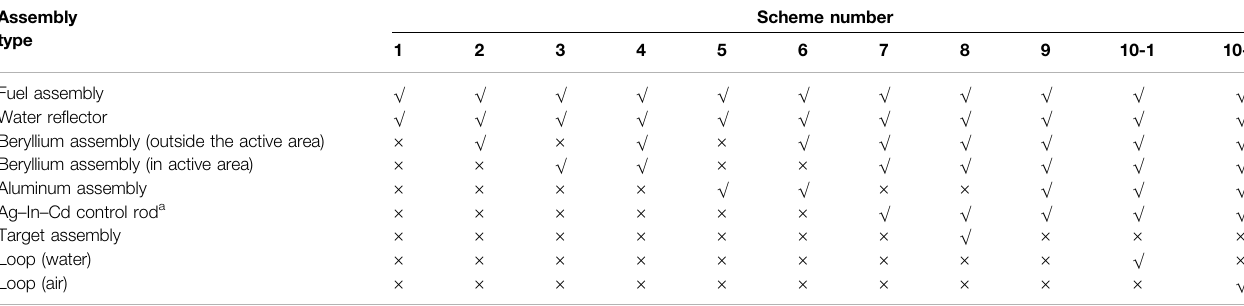
TABLE 1 | Assembly type design in the experiment schemes.